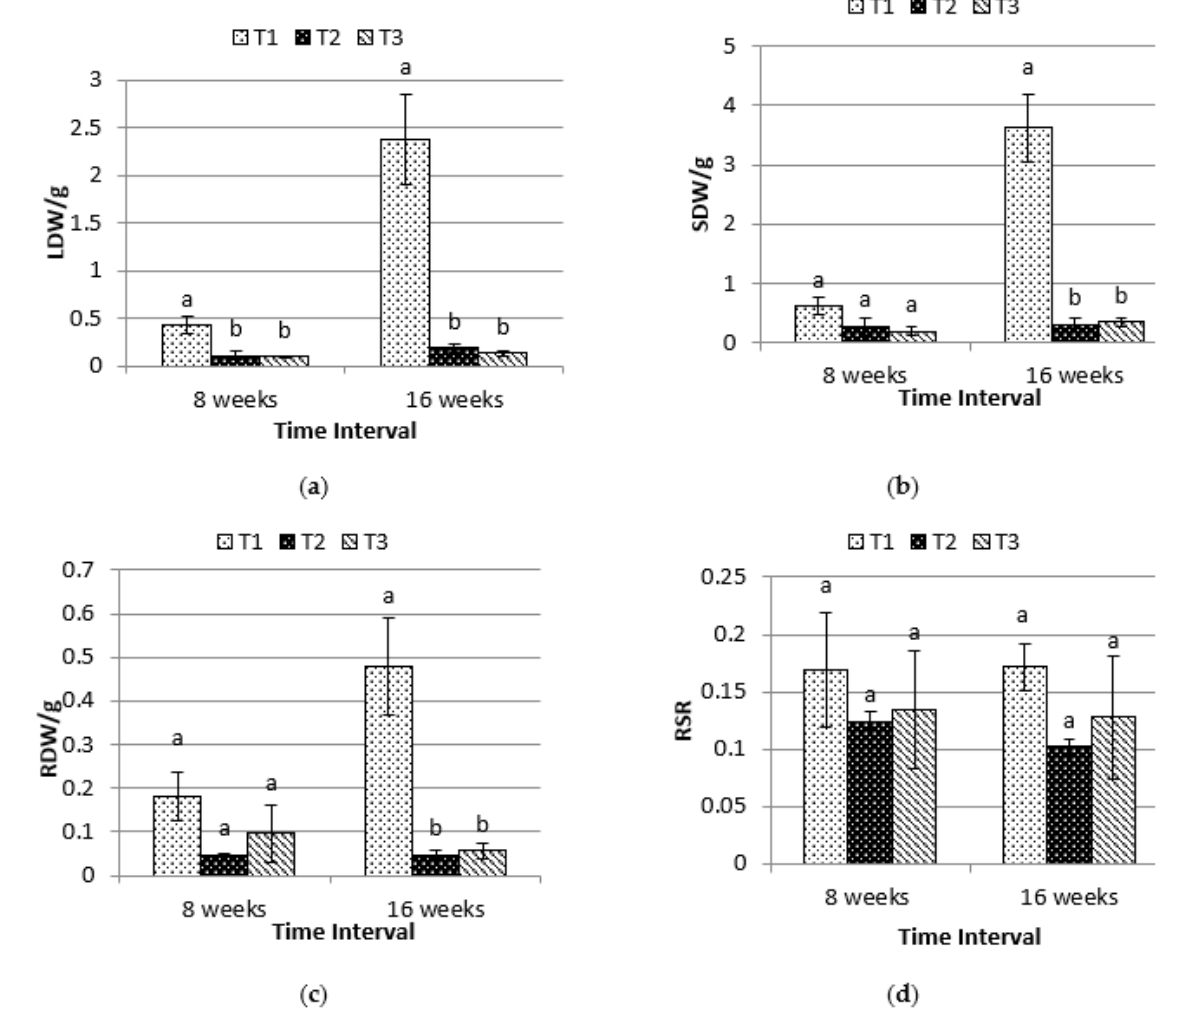
Figure 3. Effects of different shading levels (T1 = 0%; T2 = 50% and T3 = 70%) on ( a ) LDW, leaf dry weight; ( b ) SDW, shoot dry weight; ( c ) RDW, root dry weight; and, ( d ) RSR, root-shoot ratio under time interval of eight weeks and 16 weeks) (data are means of treatments, N = 48; Rep = 4; Control, T1 = 0% Shading; T2 = 50% Shading and T3 = 70% Shading; Small bars represent standard error). Means with different letters on top of each bar are significantly different at p ≤ 0.05.